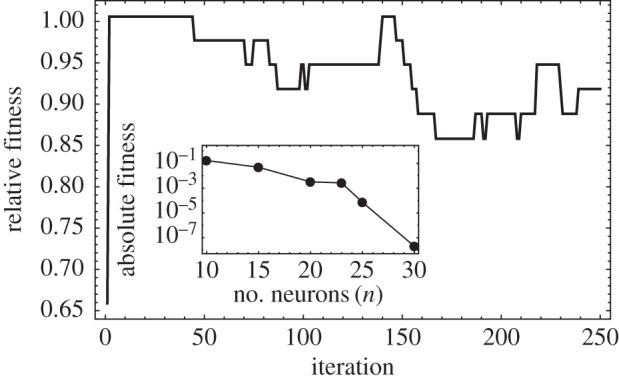
Dynamics of SSP. Example of a random realization with n = 30 neuronal loci (fitness is scaled to the maximum value). Inset: absolute fitness as a function of neuronal loci. Parameters: T = 7; otherwise as in figure 2. Synapses are assumed to have no cost.